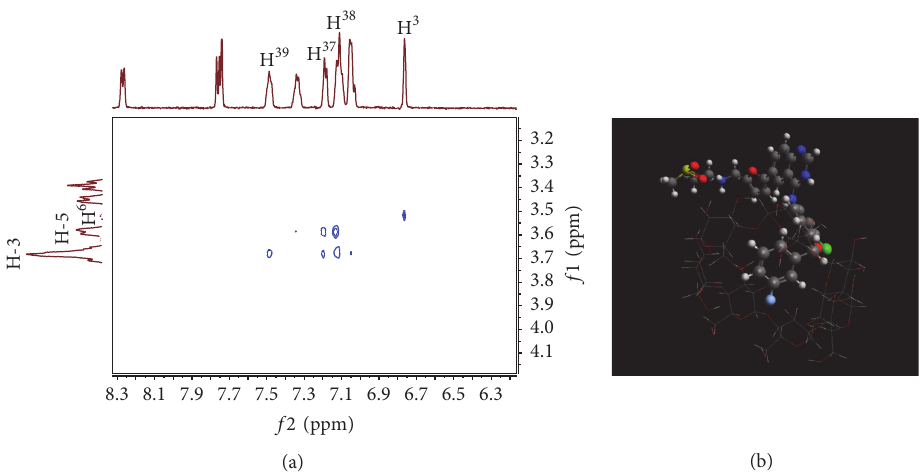
Figure 5: Determination of the LAP– 𝛽 -CD inclusion complex geometry. (a) Expansion of 2D ROESY NMR spectrum. (b) Energy-minimized structure of the complex based on the result of molecular modeling study.